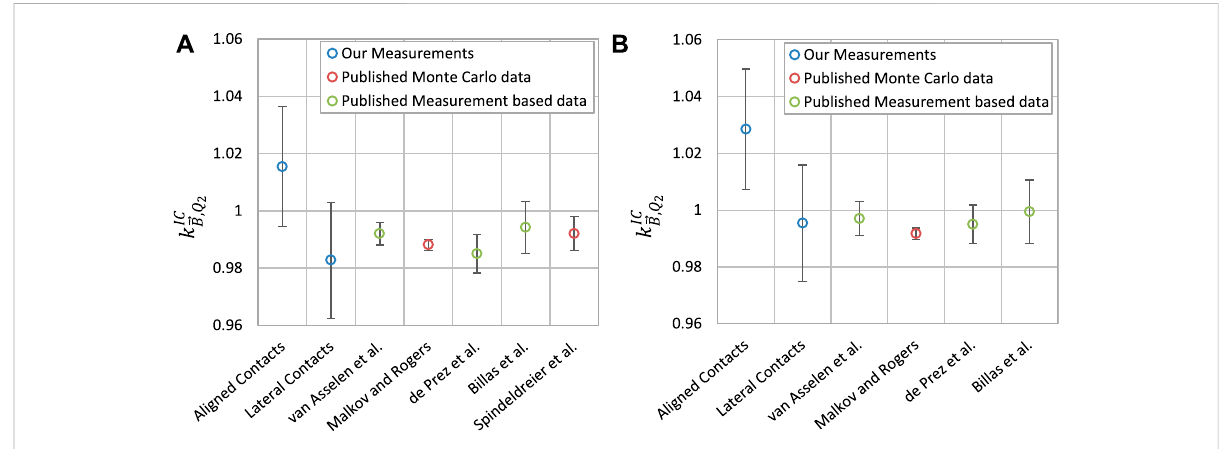
FIGURE 4 Measured k IC (cid:2) B , Q for the Elekta Unity compared to literature data for the PTW30013 (A) and IBA FC65-G (B) . Beam quality was nominally 2 TPR 20 , 10 = 0.701. All uncertainties were k = 2. The aligned and lateral contact set-ups were rotated 90 ° from each other in an edge-on orientation. Theset-upsplacedthecontactsattwodifferentpositionsrelativetothecollectingvolume.Expectedvaluesfor k IC (cid:2) B , Q are from van Asselen et al. [8], Malkov and Rogers [13], Spindeldreier et al. [14], de Prez et al. [15], and Billas et al. [16]. Published data in red was based on Monte Carlo simulations. Published data in green was based on